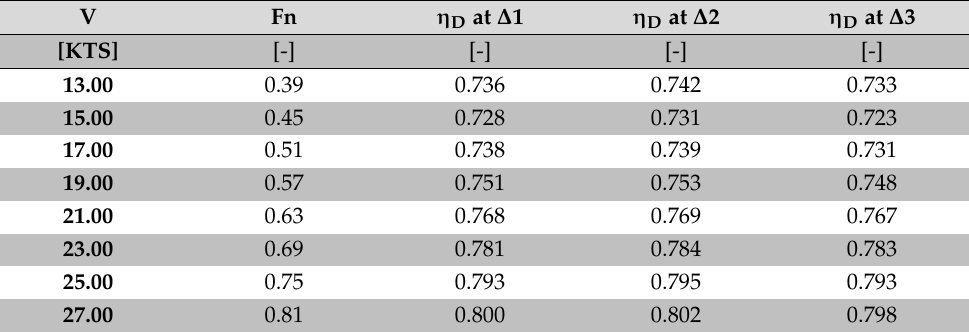
Figure 10. Comparison of dynamic trim ( left ) and sinkage ( right ) between model tests and full scale CFD for the Stavanger Demonstrator . Table 3. Experimentally measured hull and propulsive efficiencies at trial condition BF 0 for the design and off-design displacements of the Stavanger demonstrator (full scale). V: speed in knots; Fn: Froude number; η D : propulsive efficiency.